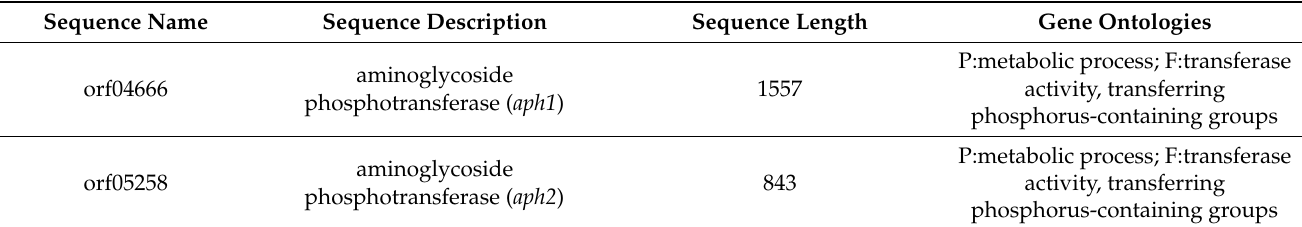
Table 2. List of antibiotic resistance-related genes in Pseudomonas sp. B14-6.